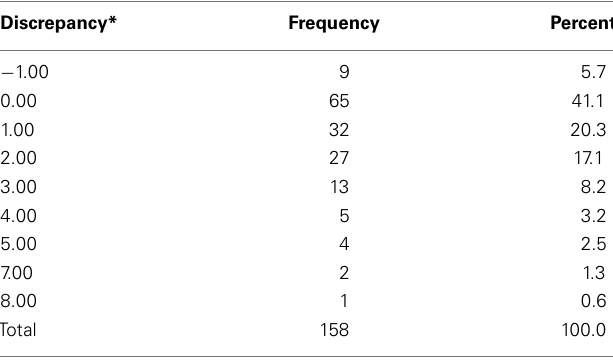
Table 1 | Number of people with a discrepancy between clinician scoring and system